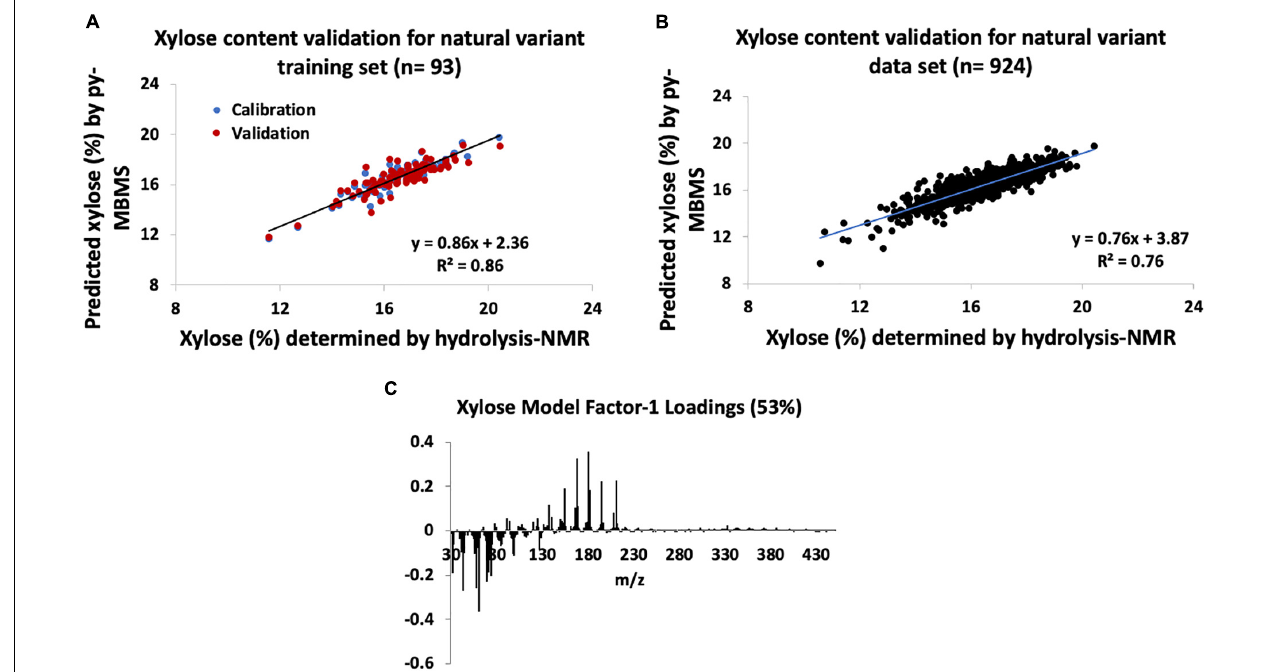
FIGURE 2 | Natural variant xylose models constructed from hydrolysis-NMR and py-MBMS spectra and validation. (A) Xylose content validation for natural variant training set, (B) xylose content validation for all natural variants tested, and (C) factor-1 spectral loadings for natural variant xylose model.